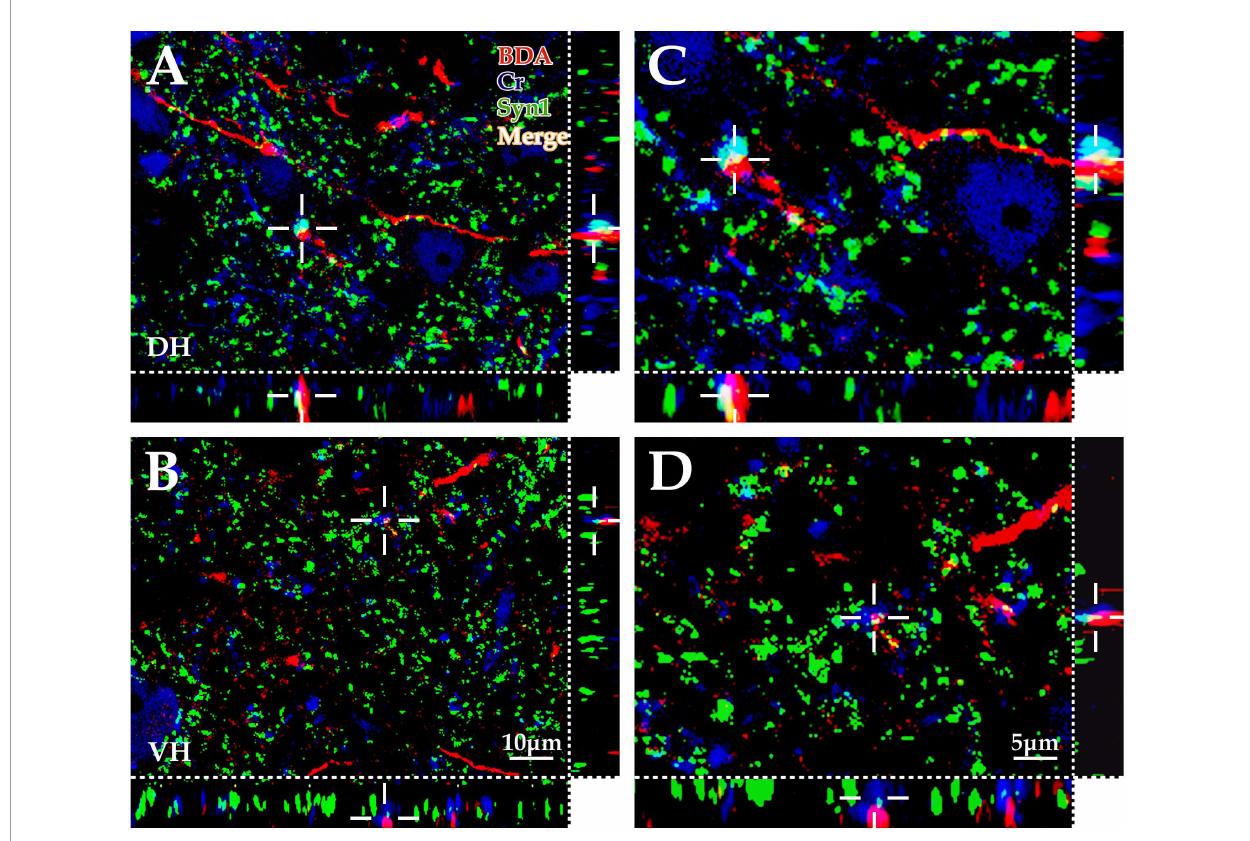
FIGURE4 Immunofluorescence exploration of the synaptic connections between BDA+ fibers and spinal Cr+ neurons. The panels above show that the cortex-spinal cord projected fibers labeled by biotinylated dextran amine (BDA) (red) formed clear appositions (white) with synaptophysin (Syn1) (green) and Cr+ neurons (blue) in the gray matter by immunofluorescence triple labeling. As shown in the above panels, a large number of BDA+ fibers (red) were observed in the dorsal horn (DH) (A,C) and ventral horn (VH) (B,D) , which was similar to the morphological appearance developed by DAB shown in Figure 1 . Moreover, a large number of Cr+ dendrites and somas (blue) were observed, and Syn1-positive structures presented granulate and patch appearances (green). The apposition points (white) of three structures were observed with three-dimensional recomposition, which was labeled with the cross symbol (+). The abbreviations in this figure are the same as in Figure 2 . (A,B) Show the same magnification with a scale bar = 10 µ m. (C,D) Are the high magnification views of (A,B) , respectively. The cross symbol (+) in (C,D) is the same apposition in (A,B) , respectively. The magnifications of (C,D) are the same, scale bar = 5 µ